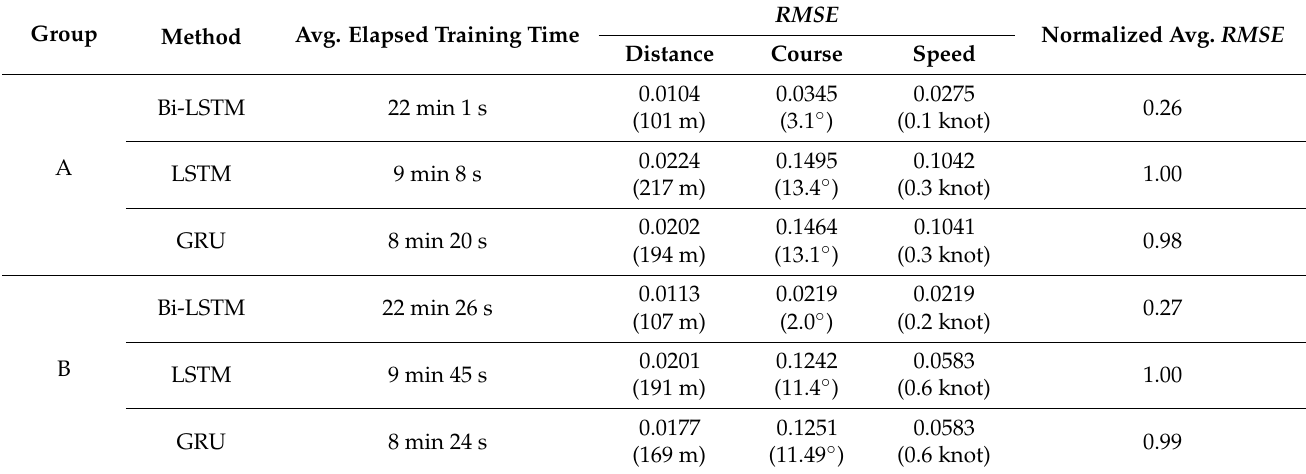
Figure 9. Comparison of distance RMSE for each model. Table 3. Results comparison among BLSTM, LSTM, and GRU.